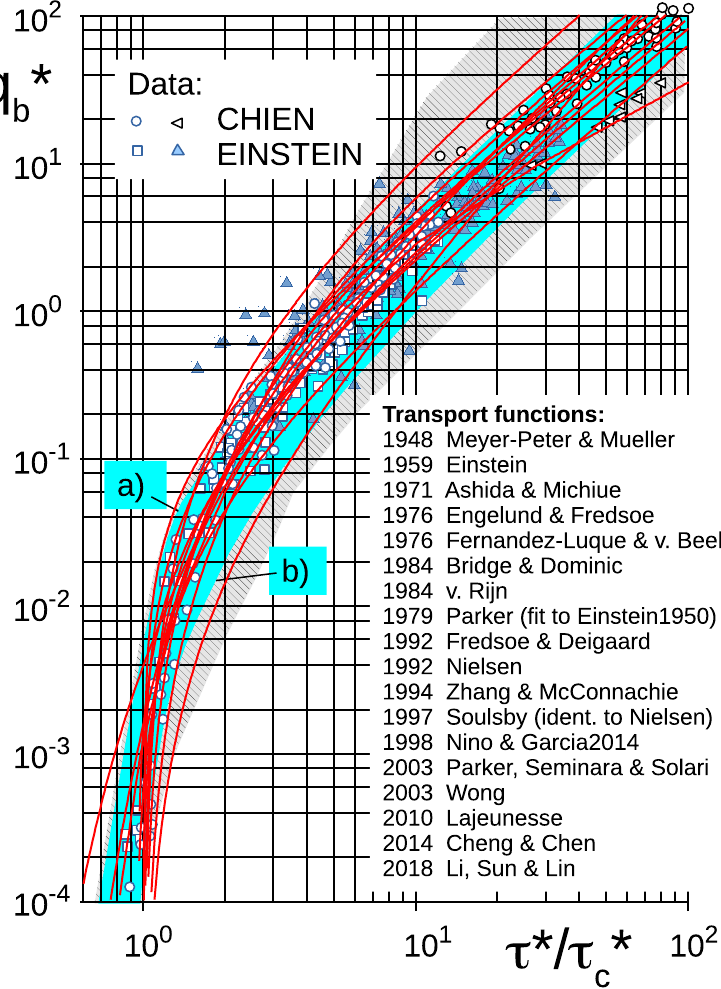
Figure 7. Bandwidth of Equations (20) and (21) due to di ff erent ϕ o and ϕ d : Blue area: hydraulically rough conditions (edges of the blue area are denoted by (a) and (b)). Dashed area: transitional and hydraulically smooth